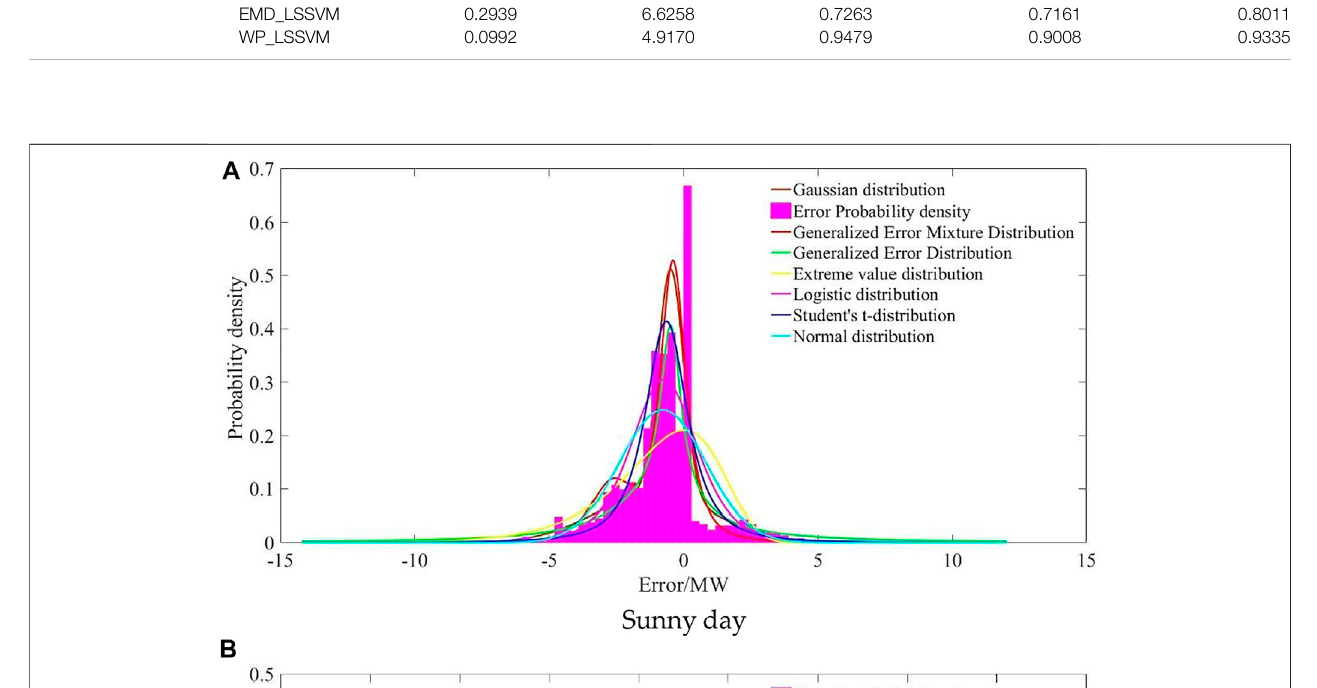
Frontiers in Energy Research |